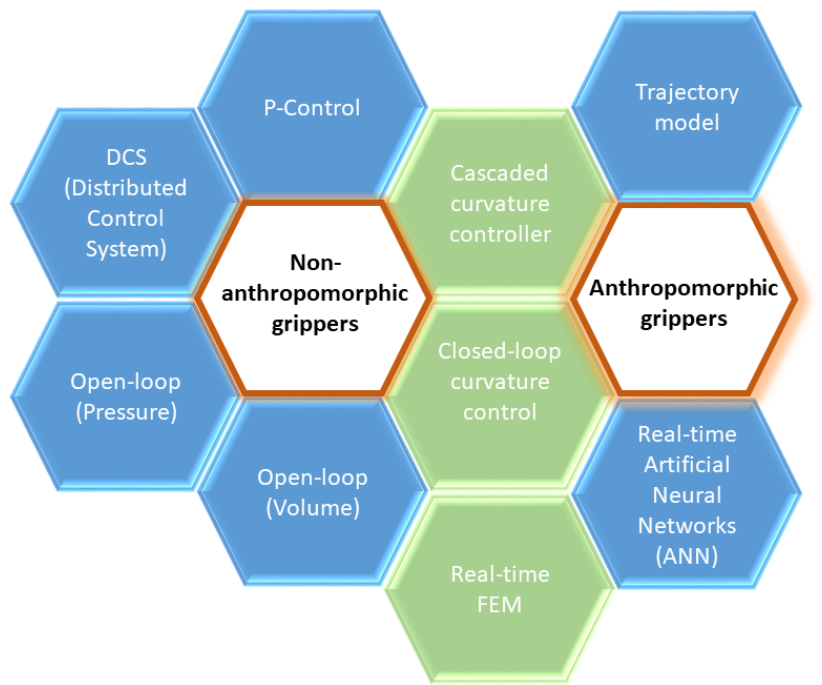
Figure 7. Several control philosophies proposed for FEA-type soft actuators. The control philoso- phies that have been proposed for a particular type of soft gripper (anthropomorphic or non- anthropomorphic) are presented in blue, while those proposed for both types are shown in